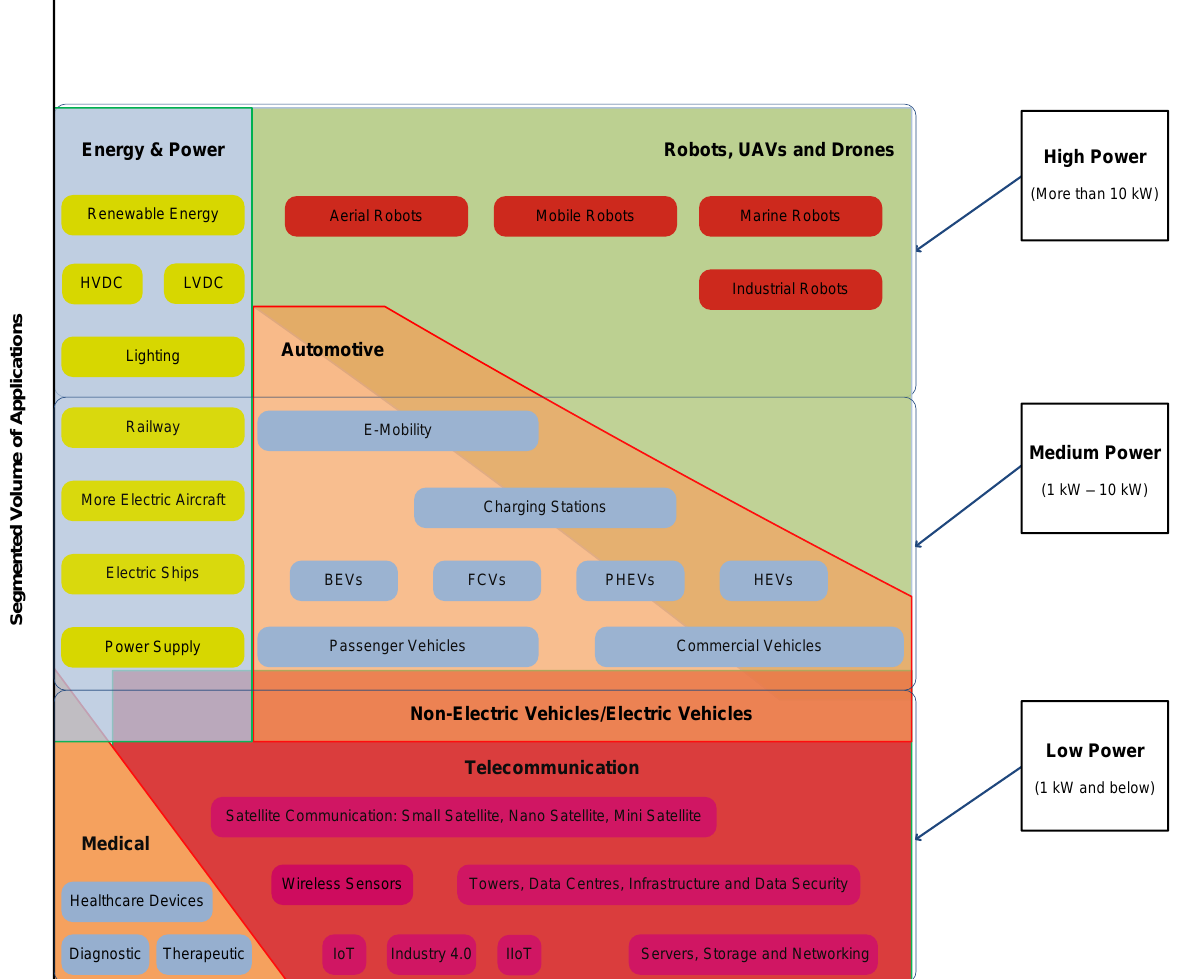
Figure 13. Multiple-Output DC–DC Converters Applications.